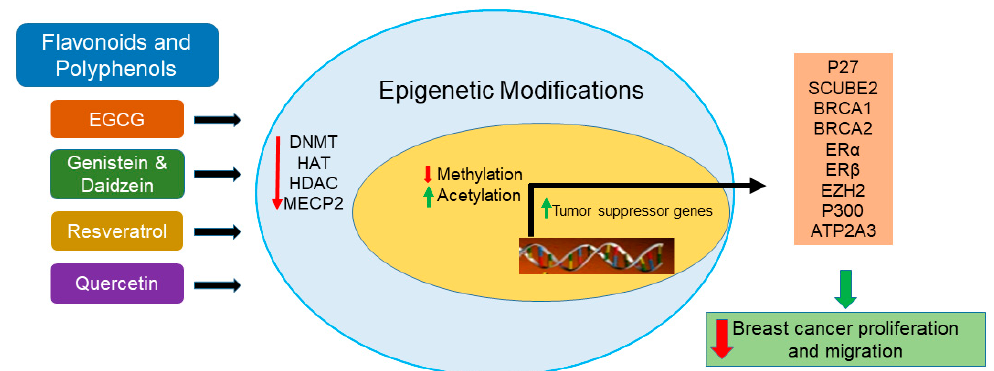
Figure 1. Schematic representation of the action of flavonoids and other polyphenols on epigenetic modifications and induction of tumor suppressor genes.